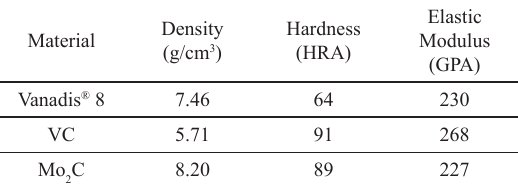
Table 2. Density, hardness and elastic modulus of the Vanadis ® 8 steel and the VC and Mo C carbides. 2 Material